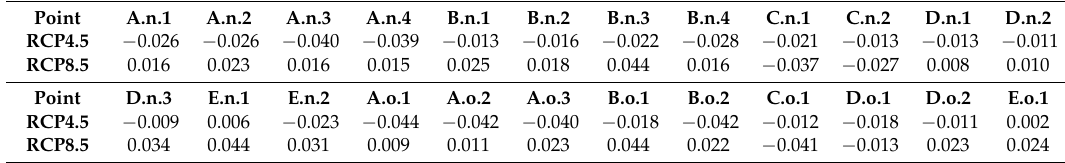
Table 6. Linear trend (m/s per decade) values computed for all 24 points for near future data.